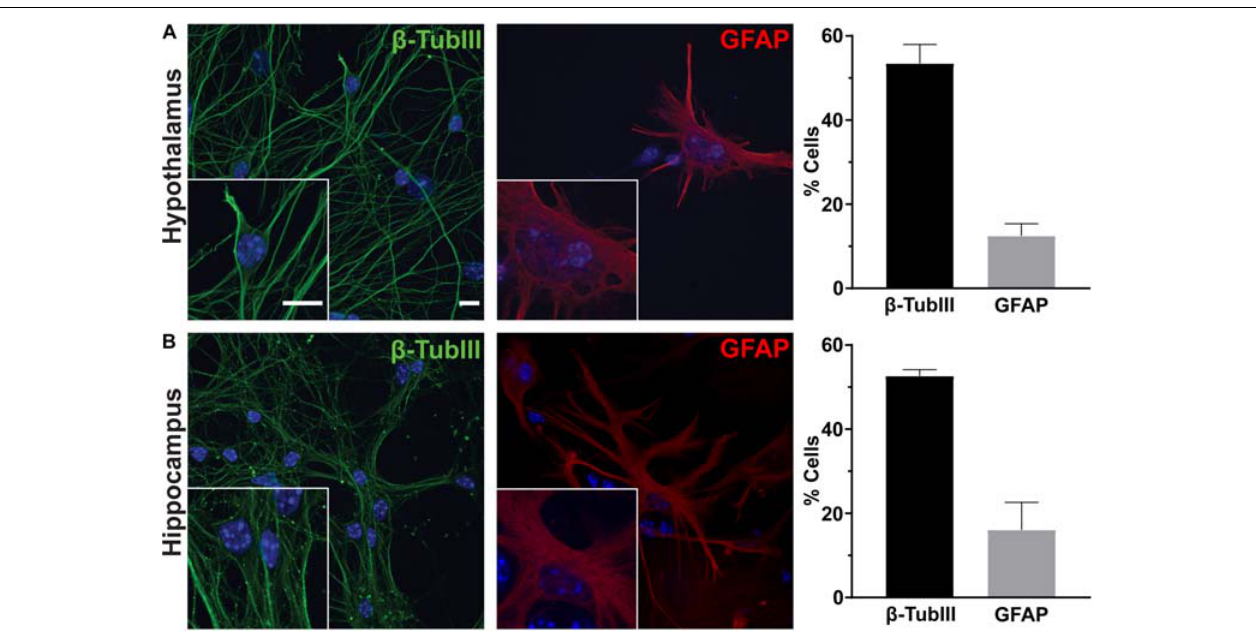
FIGURE 1 | Hypothalamic and hippocampal culture content. Hypothalamic (A) and hippocampal (B) cultures from perinatal mice contain neurons [ β -tubulin III ( β -TubIII), green] and glia [glial fibrillary acidic protein (GFAP), red] after 7 days in culture. The percentage of cells positive for the associated stain divided by the total number of cells counted per hypothalamus or hippocampus is graphed as mean ± SEM. Hoechst stained nuclei are blue. Scale bars are 10 µ m. Data collected from 3 hypothalamic and hippocampal samples from 3 experimental days. β -tubulin III positive cells/total hypothalamic nuclei: 336/628, GFAP positive cells/total hypothalamic nuclei: 126/647, β -tubulin III positive cells/total hippocampal nuclei: 323/613, and GFAP positive cells/total hippocampal nuclei: